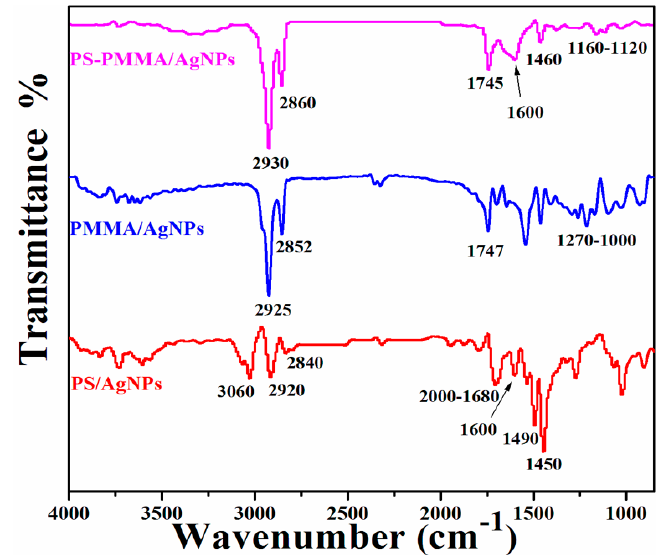
Figure 2. FTIR spectra of polymer/AgNPs nanocomposites.